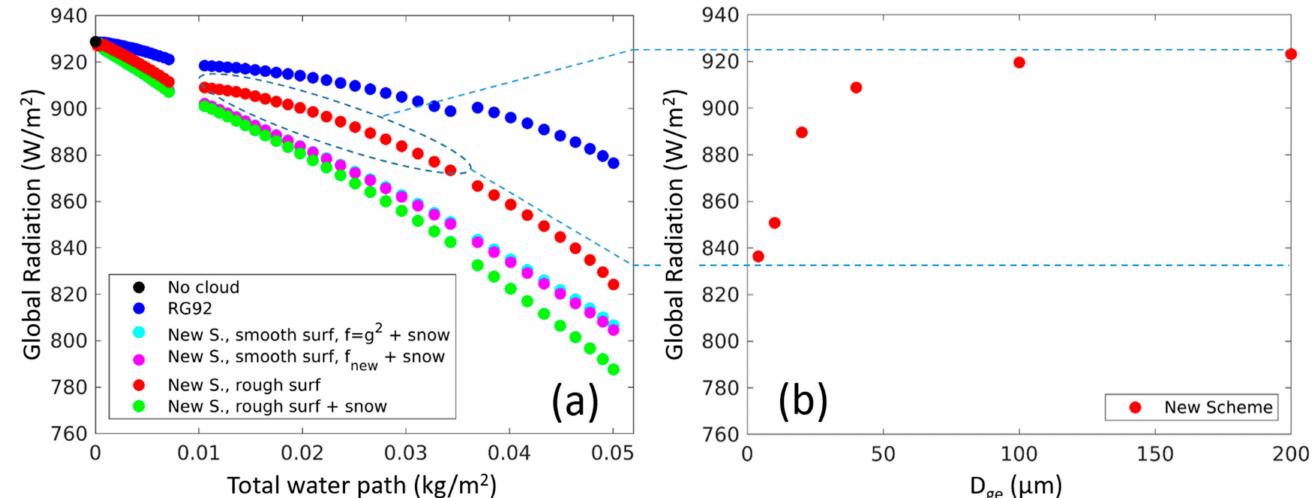
Figure 7. ( a ) Global radiation versus ice water path for 3 experiments of cirrus. The clear sky reference is marked by a black dot. In blue dots the default COSMO radiation scheme RG92, red dots represent simulation which assumes rough ice particles surfaces and ignoring snow particles, lime green dots is the result when snow particles are considered, the same but assuming smooth surfaces are in magenta and the last, in cyan, is similar to the previous but using the forward scattered fraction approximation of f = g 2 instead of the Fu (2007) [18] formulas. ( b ) Global radiation in the third version of the new scheme (red dots) versus cloud-averaged ice particles effective diameter for experiment 2 of cirrus (see Table 1) marked by the dashed circle. The range of variation in global radiation due to change in ice particles effective diameter is marked by dashed